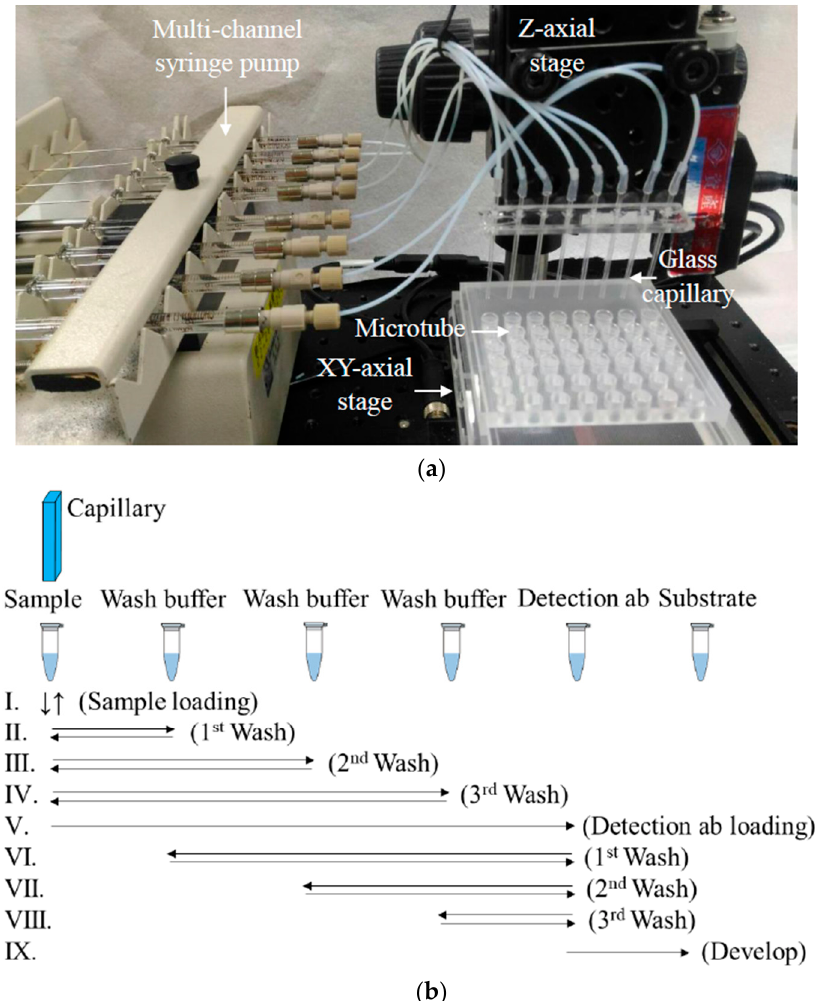
Figure 2. The experimental setting and control of the automatic glass capillary immunoassay platform. ( a ) The glass capillaries are held on the vertically movable Z stage and connected to a multi-channel syringe pump. Add the reagents and samples in the prearranged microcentrifuge tubes, which are carried by the motorized XY stage. The above setting is used to perform the immunoassay protocol outlined in ( b ) in the following order: sample loading, incubation, washing, detection antibody loading, incubation, washing, chemiluminescence substrate loading, and incubation.